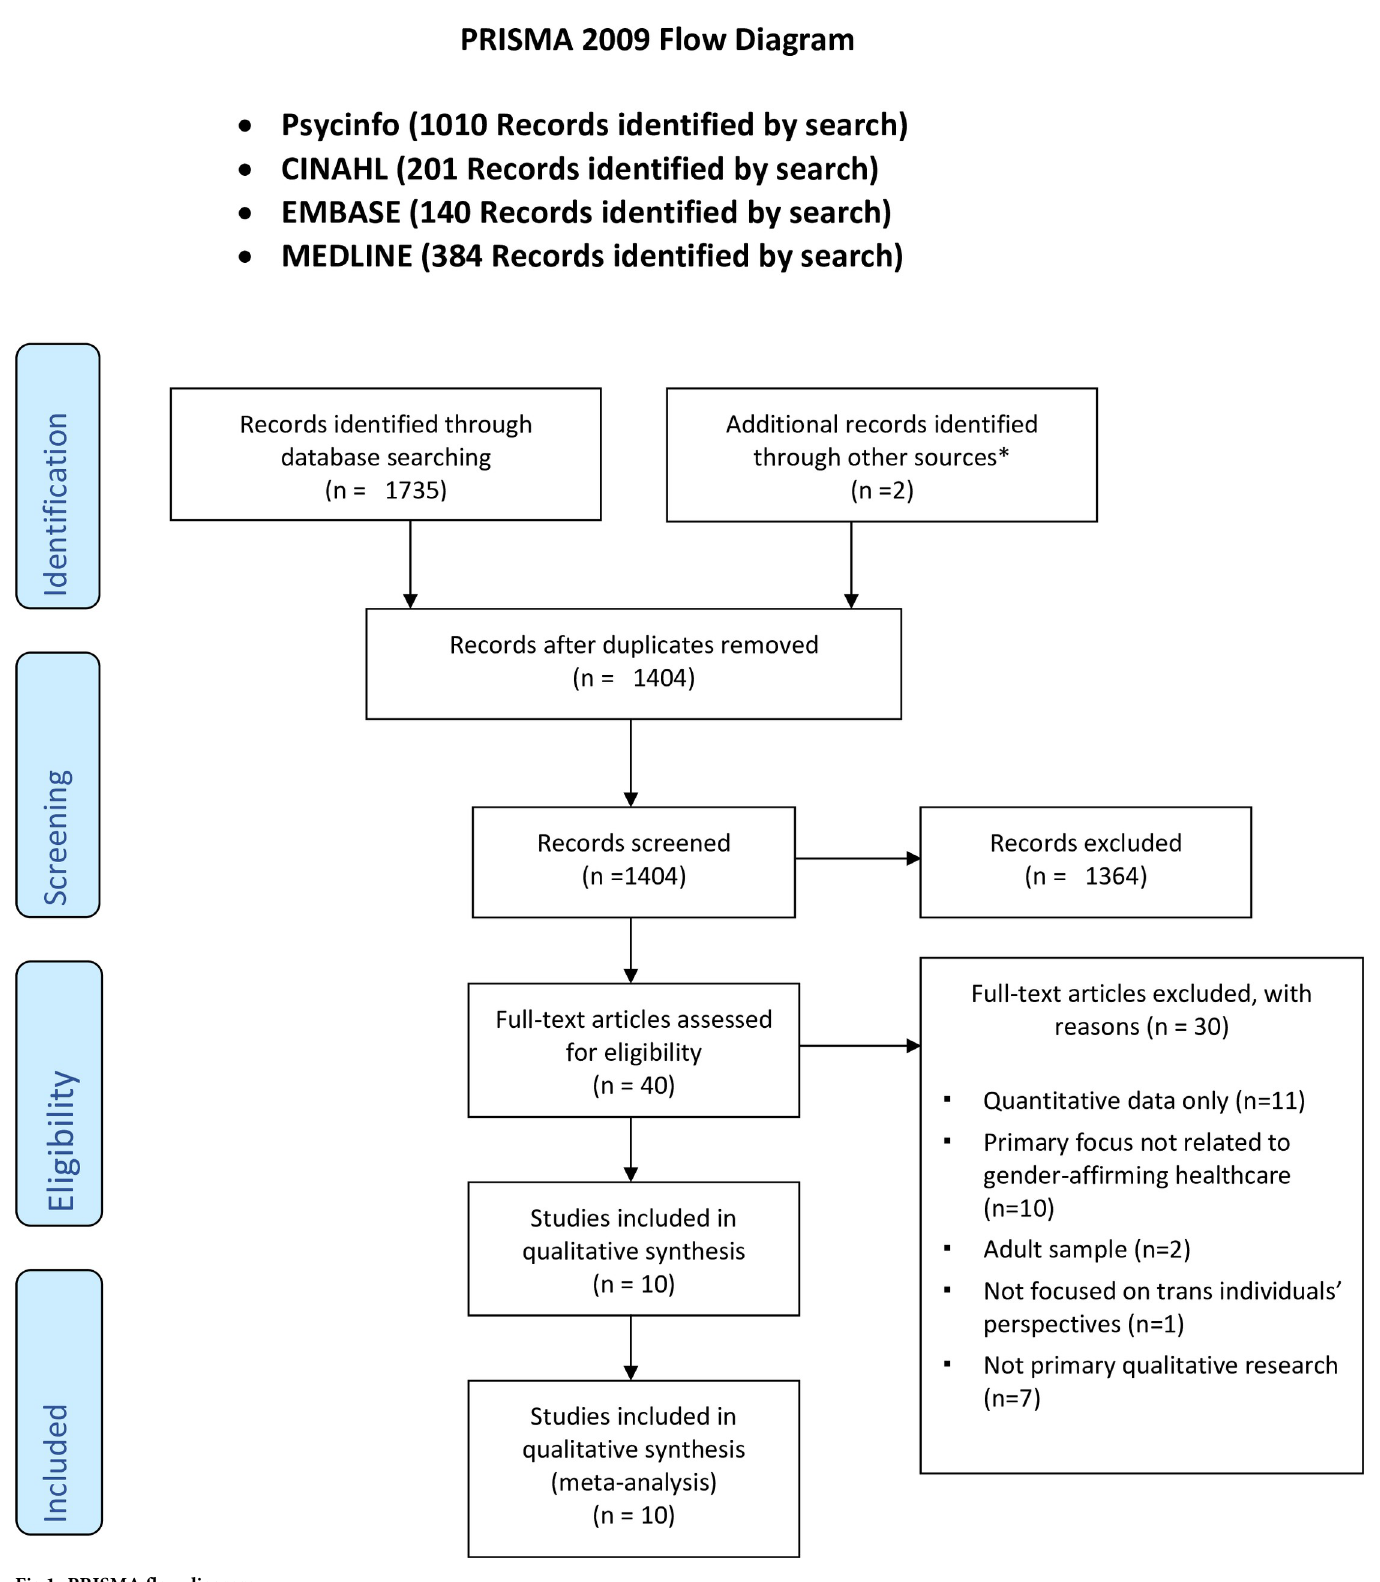
Fig 1. PRISMA flow diagram.